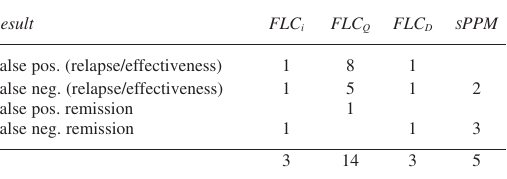
Table 2. sFLCA vs. PPM. Frequency of false